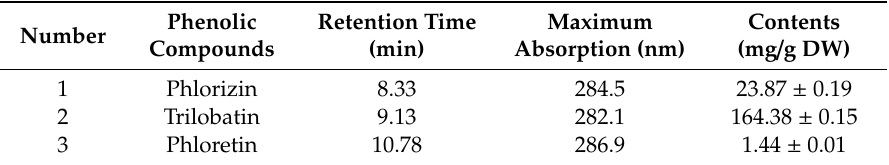
Table 7. The contents of phenolic compounds in L. polystachyus leaf extract obtained under the optimal